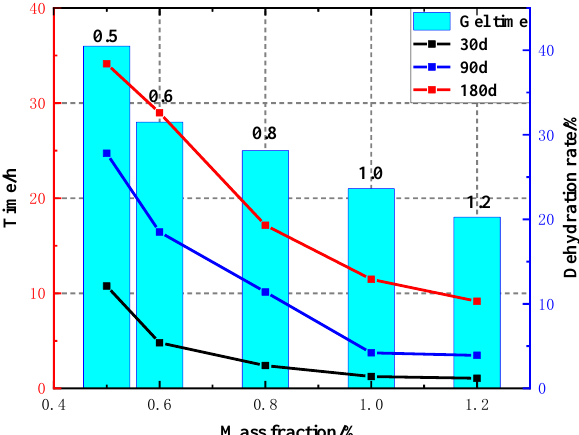
Figure 5. Effect of the polymer mass fraction on the stability of frozen gel. Note that the left y-axis values in Figure 5 is used for histograms, and the right y-axis values are used for the line charts; 30 d/90 d/180 d represent 30 days, 90 days, 180 days of dehydration, respectively.